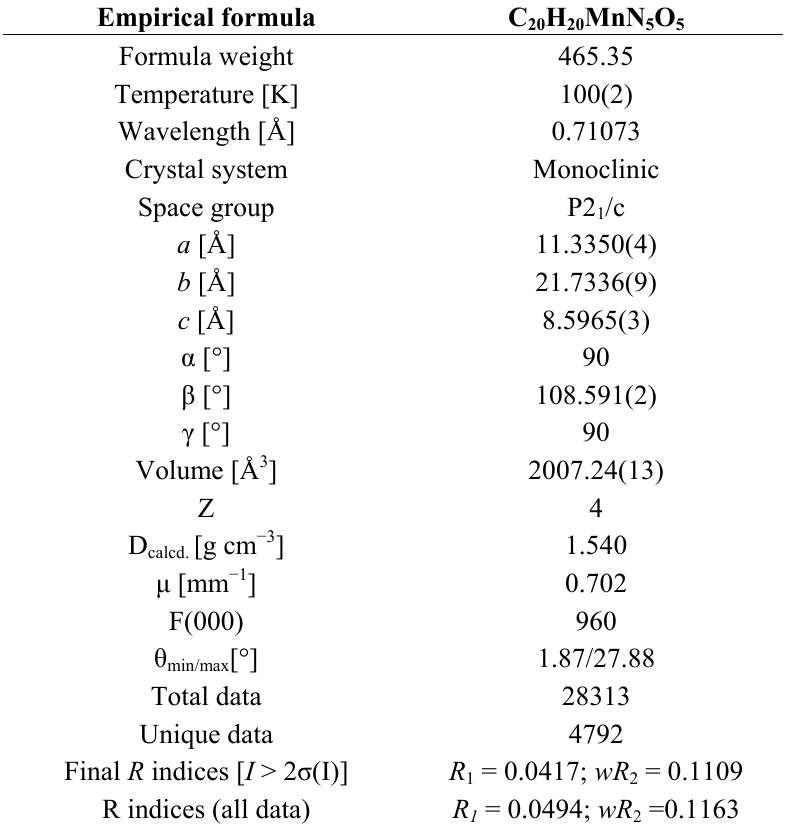
Table 3. Crystal data and structure refinement for 4